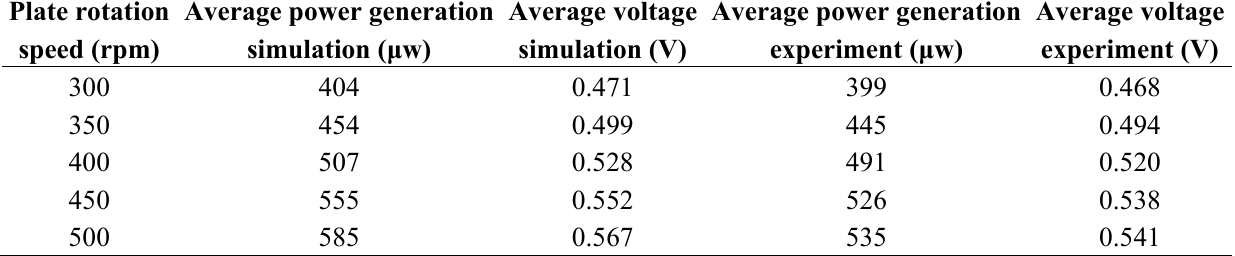
Table 2. Output voltage and power at constant plate rotation